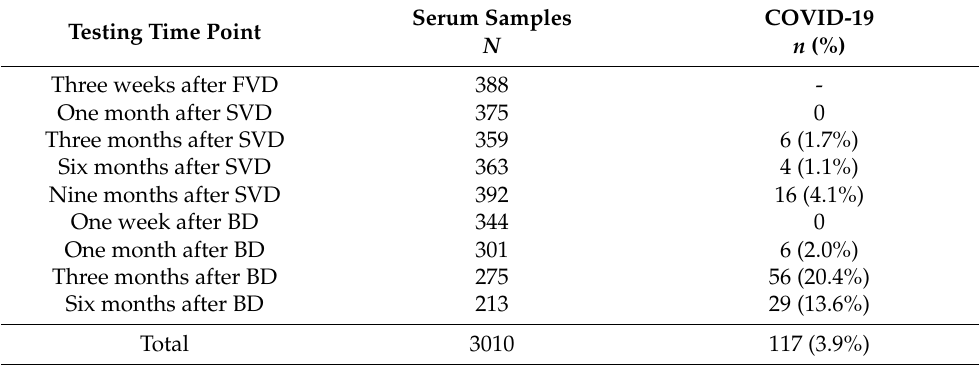
Table 1. Serum samples and acquired COVID-19 after vaccination by testing time